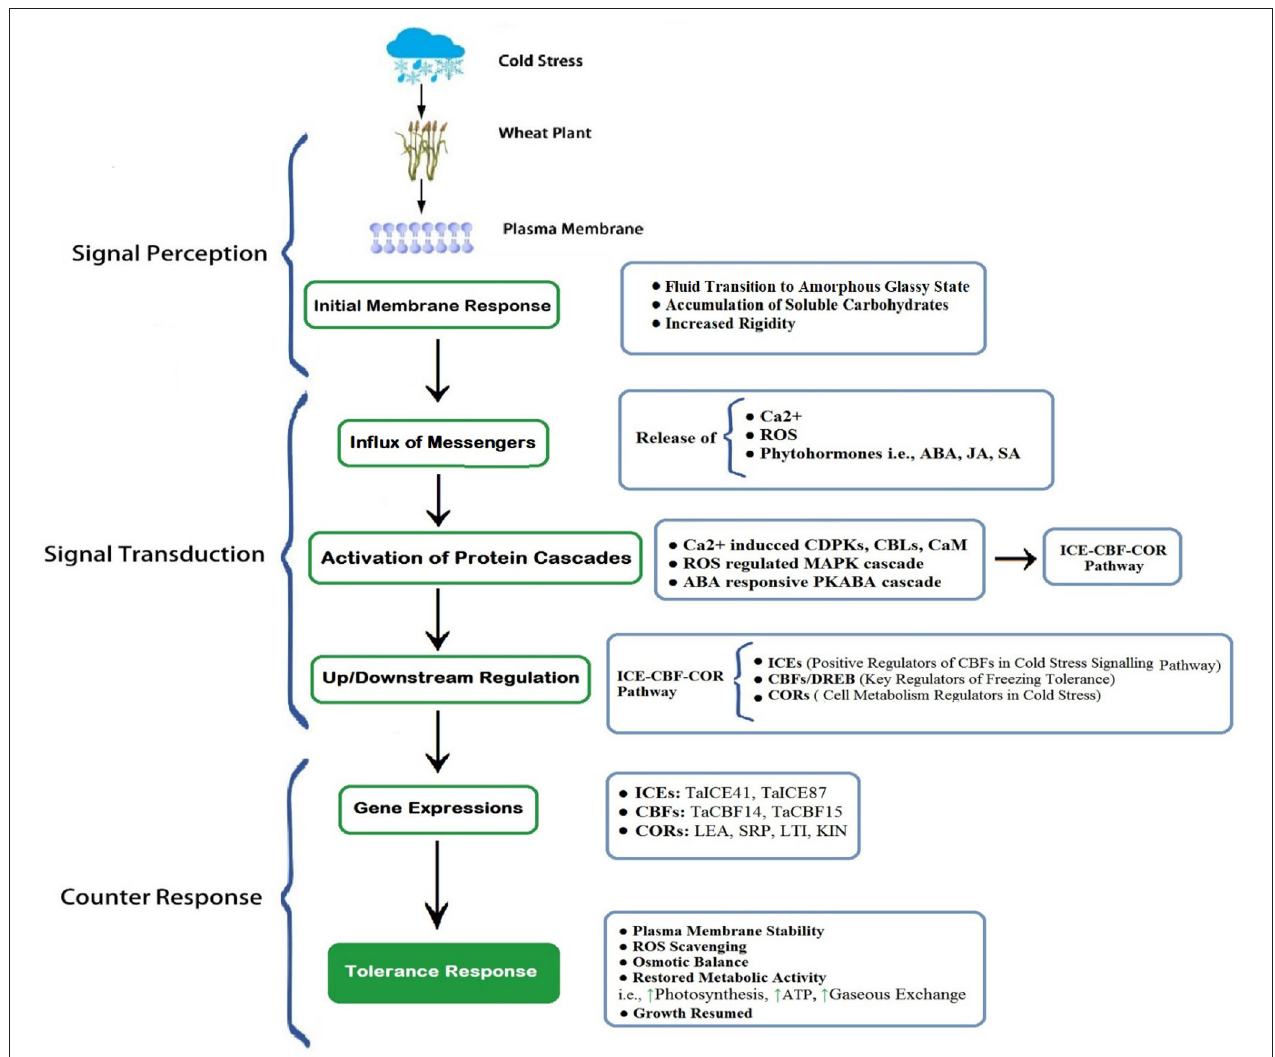
FIGURE 4 | A schematic exhibition of cold perception, transduction, and final counter-response of wheat. The plasma membrane is the first site to perceive cold stress. Membrane rigidity increased with the accumulation of carbohydrates and inside fluid transited to less mobile (gel) or amorphous glassy state. Subsequently, the influx of receptors (Ca 2 + , ROS, Phytohormones), initiation of cascades of protein kinases, and protein cascade-driven up/downstream regulation generate gene expressions to aid cold tolerance (Modified from Guo et al., 2018, 2019). [Here, ↑ indicates enhanced activity]. ROS, Reactive Oxygen Species; ABA, Abscisic Acid; JA, Jasmonic Acid; SA, Salicylic Acid; CDPKs, Ca 2 + -Dependent Protein Kinase; CBL, Calcineurin B-like Proteins; CaM, Calmodulin Proteins; MAPK, Mitogen-Activated Protein Kinase; PKABA, Protein Kinase induced by ABA; ICE, Inducer of CBF Expressions; CBF, Carbon Repeating Binding Factor; COR, Cold Responsive